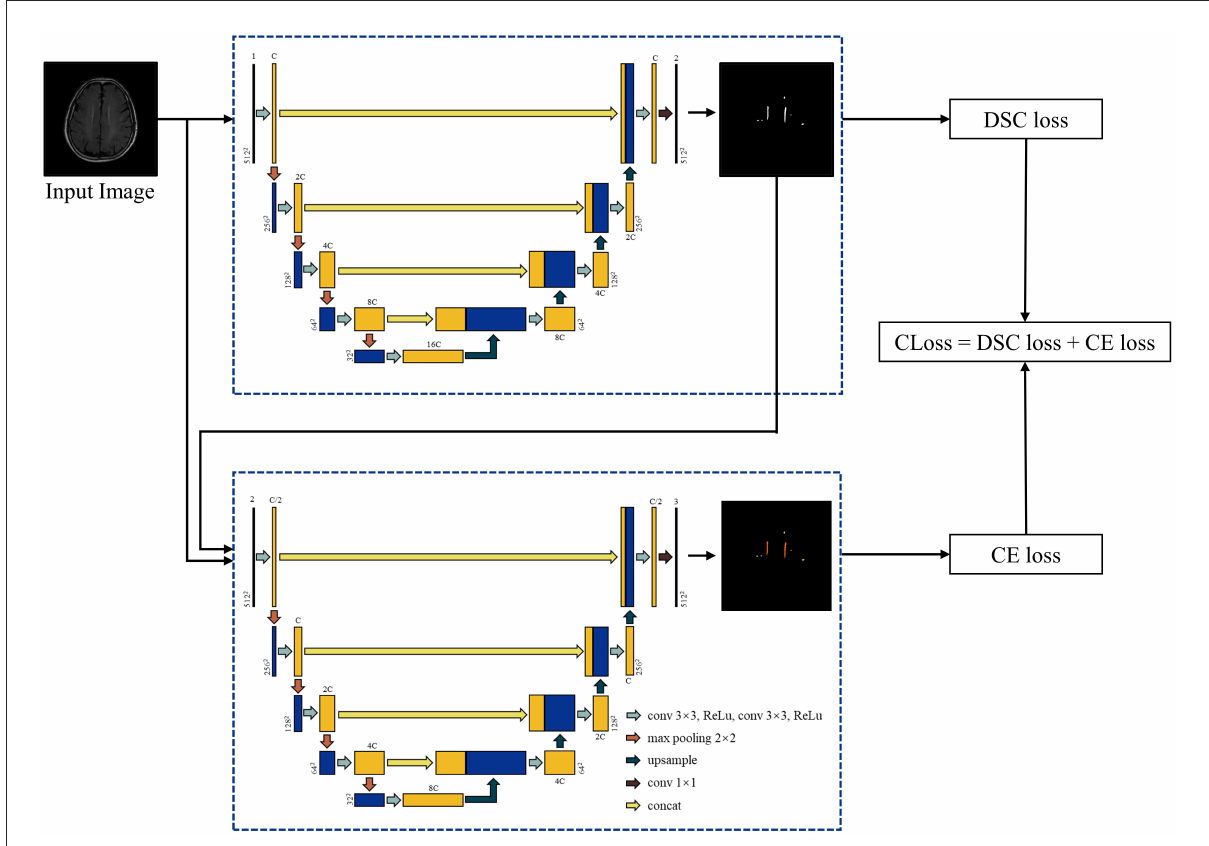
FIGURE2 Architecture of Cascade U model. C represented the channel number of Cascade U model in the first layer and was selected as 64 in the present study.